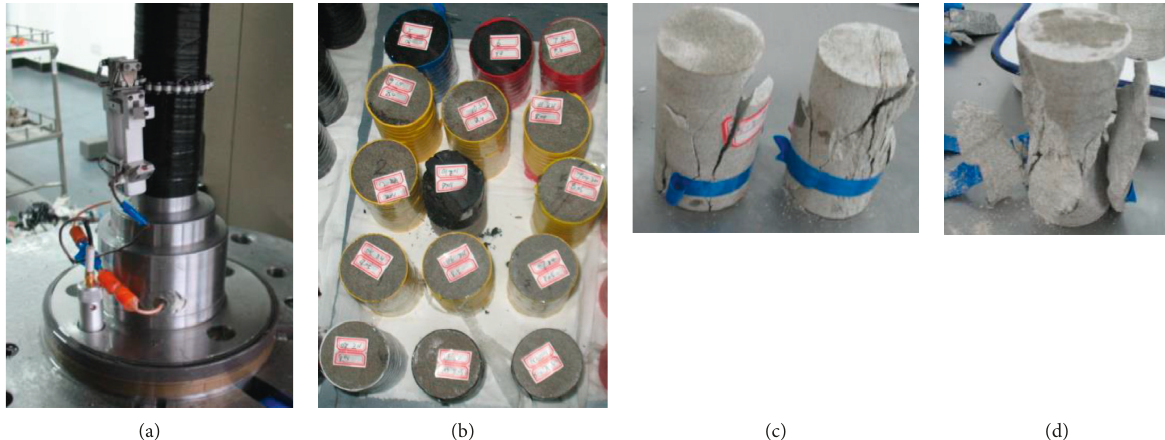
Figure 3: Test process and rock samples after testing.